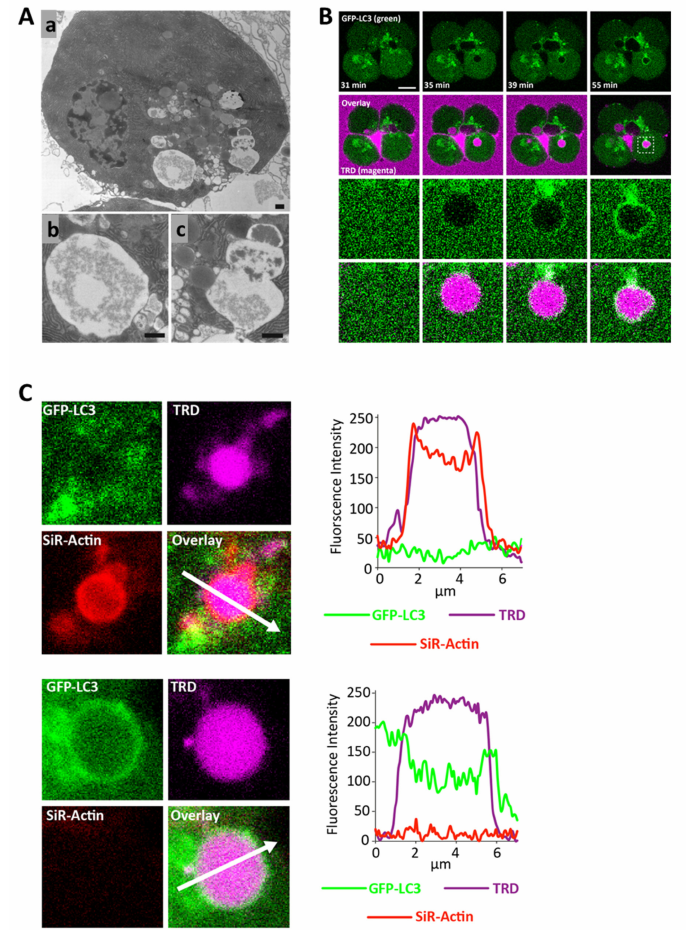
Figure 1. Formation, actination and LC3 conjugation of endocytic vacuoles. ( A ) Electron microscopy of endocytic vacuole and postendocytic structure (adapted with modifications from [13], copyright 2007 by The National Academy of Sciences of the USA). All scale bars correspond to 0.5 µ m. ( Aa ) Pancreatic acinar cell stimulated with a high concentration of CCK (10 nM). ( Ab ) Enlarged fragment containing endocytic vacuole. ( Ac ) Post-endocytic structure, (i.e., precursor of an endocytic vacuole) formed as a result of compound exocytosis. Note the gradient of secretory material in the post- endocytic structure and the adjacent zymogen granules. ( B ) Formation and LAP-like non-canonical autophagy of an endocytic vacuole (adapted with modifications from [9]. Endocytic vacuoles, formed in pancreatic acinar cells as a result of CCK stimulation, are revealed by endocytosed Texas Red dextran (shown by the magenta colour in the figure). The cells were isolated from GFP-LC3 transgenic mice (GFP-LC3 is represented by the green colour in the figure). The upper two rows show the events in a cluster composed of four cells. Scale bar corresponds to 10 µ m. The fragment (outlined by dash lines on the right overlay image) is shown in the two lower rows. Note the rapid LC3 conjugation to the endocytic vacuole. For further details see [9]. ( C ) Actination and LC3 conjugation of endocytic vacuoles formed in a CCK-stimulated pancreatic acinar cell (adapted with modifications from [9]). The cells were isolated from GFP-LC3 transgenic mice (GFP-LC3 is represented by the green colour in the figure). The endocytic vacuoles are revealed by endocytosed Texas Red dextran (shown by magenta colour in the figure). The F-actin is identified by SiR-actin staining (shown in red colour in the figure). The upper and lower panels represent fragments of confocal images shown in [9]. The upper panel depicts an actinated endocytic vacuole, which is coated with LC3. The lower panels show an LC3-conjugated endocytic vacuole, which is not actinated. The right parts of the panels show profiles of fluorescence intensities recorded along the corresponding white arrows. For further details see